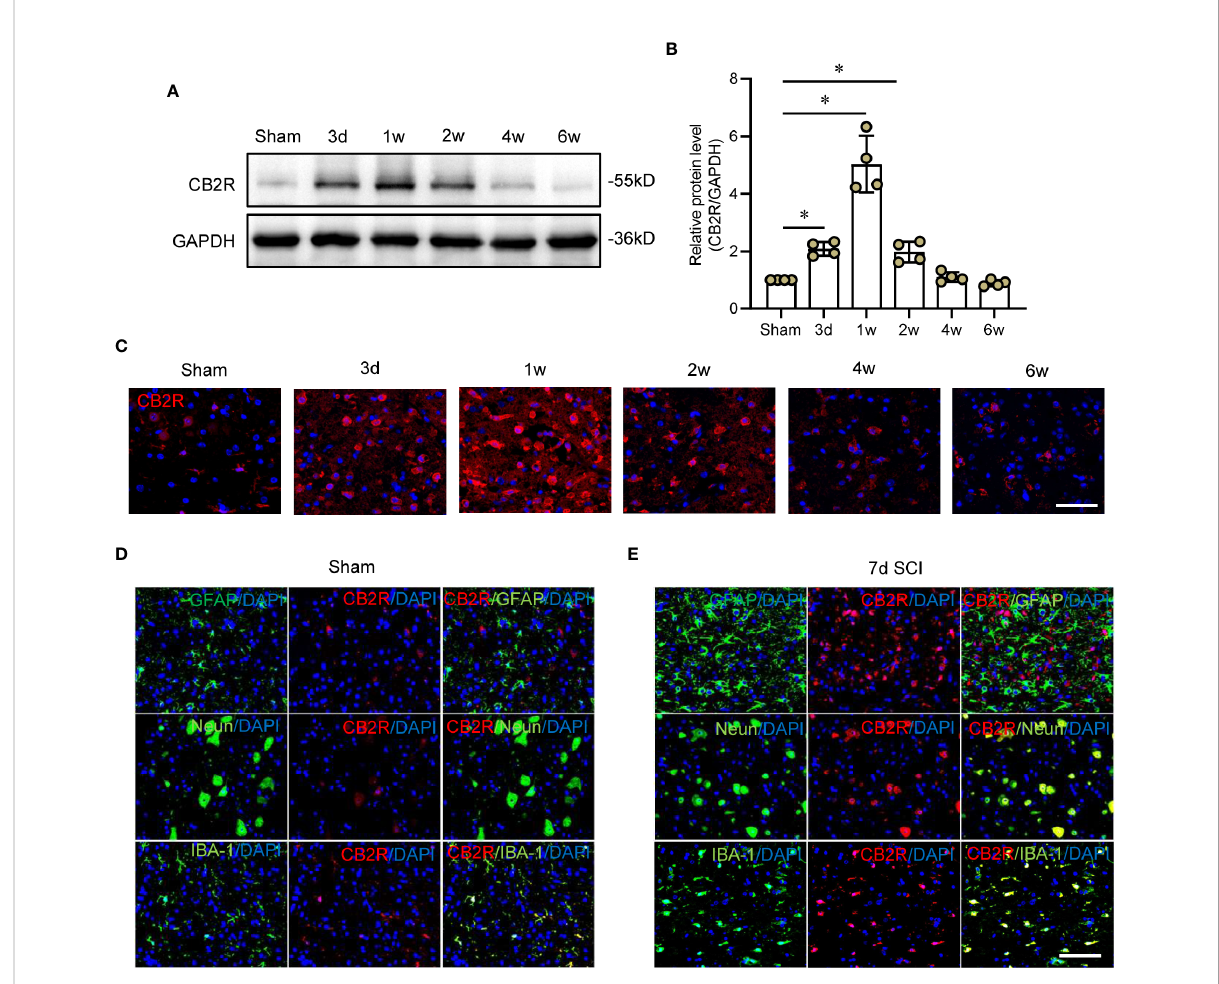
FIGURE 1 Expression patterns of CB2R in cord tissues post-SCI. (A) Representative protein band of CB2R on day 3 and weeks 1, 2, 4, and 6 post-SCI. (B) Quantitative analysis showing that CB2R expression was signi fi cantly increased on day 3 and weeks 1 and 2 post-SCI. (C) IF staining showing that CB2R (red) in cords of mice within 6W post-SCI. (D) IF staining of CB2R (red) with GFAP, Neun, or IBA-1 (green) in cords of sham mice. (E) IF staining of CB2R (red) with GFAP, Neun, or IBA-1 (green) in SCI mice on day 7 post-SCI. Scale bar = 100 m m. * p <